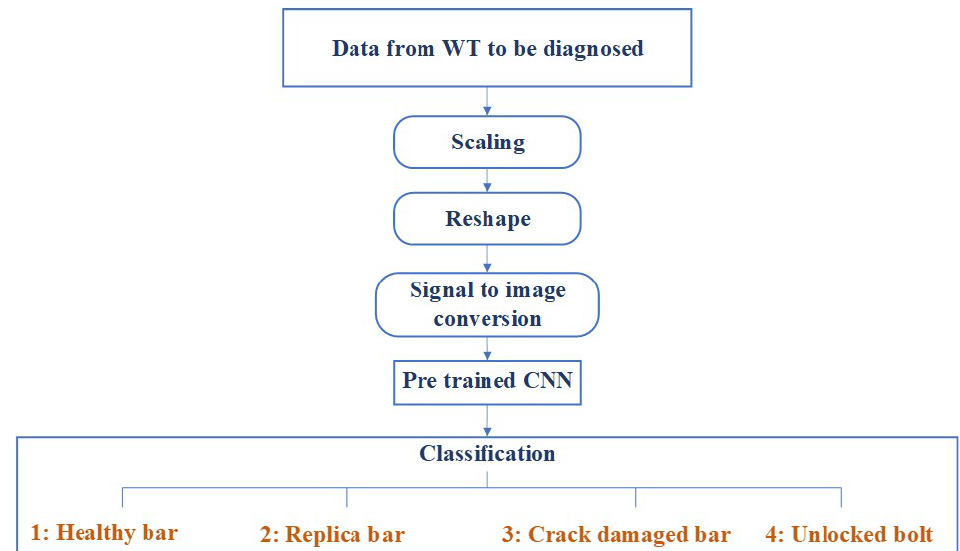
Figure 7. Flowchart to illustrate how the proposed structural health monitoring (SHM) strategy is applied when a wind turbine (WT) must be